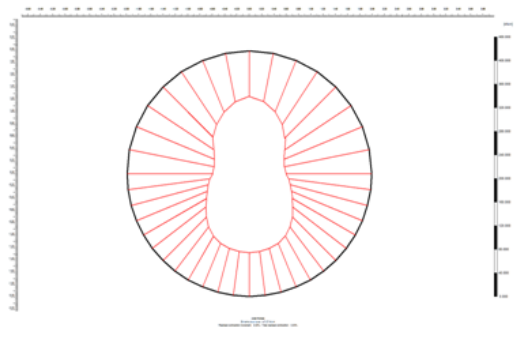
Figure 7. The diagram of axial force for sand backfill ( N max = 147 . 87 kN)